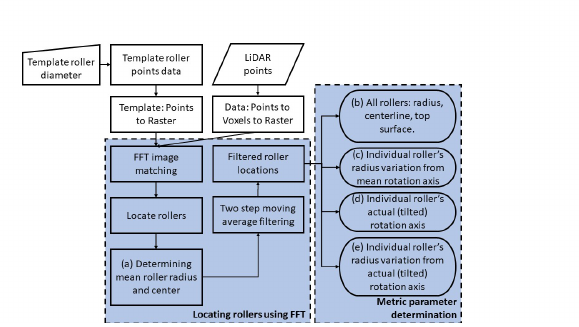
Figure 7. Steps to extract roller properties.